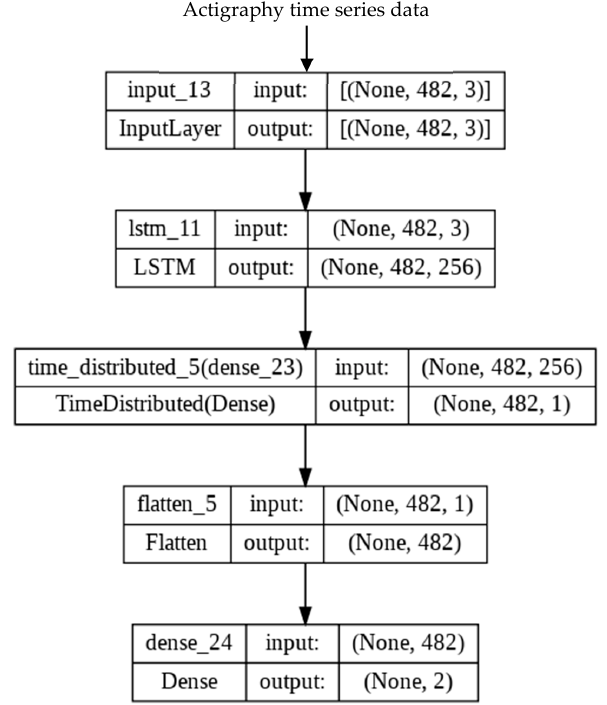
Figure A2. Configuration of LSTM model used for experiment with only time series data.